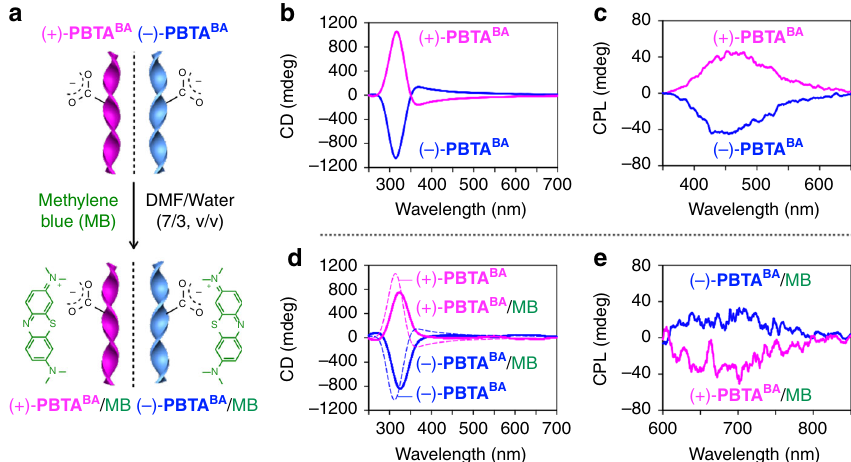
Fig. 4 Chiral environment of the cation-binding sites in PBTA BA nanoribbons. a Schematic representation of the binding of methylene blue (MB) onto PBTA BA at its carboxylate units via an electrostatic interaction. b , c Circular dichroism (CD, b ) and circularly polarized luminescence (CPL, λ ext = 290 nm, c ) spectra at 25 °C of DMF/water (7/3, v/v; 1 mL) suspensions of ( − )- PBTA BA (blue) and ( + )- PBTA BA (pink) ([ BTA BA ] = 5.3 mM, Fig. 2d, e). d , e CD ( d ) and CPL ( λ ext = 550nm, e ) spectra at 25 °C of DMF/water (7/3, v/v; 1 mL) suspensions of ( − )- PBTA BA (blue) and ( + )- PBTA BA (pink) ([ BTA BA ] = 5.3 mM) containing MB ([MB]/[ BTA BA ] = 20%). Source data are provided as a Source Data fi